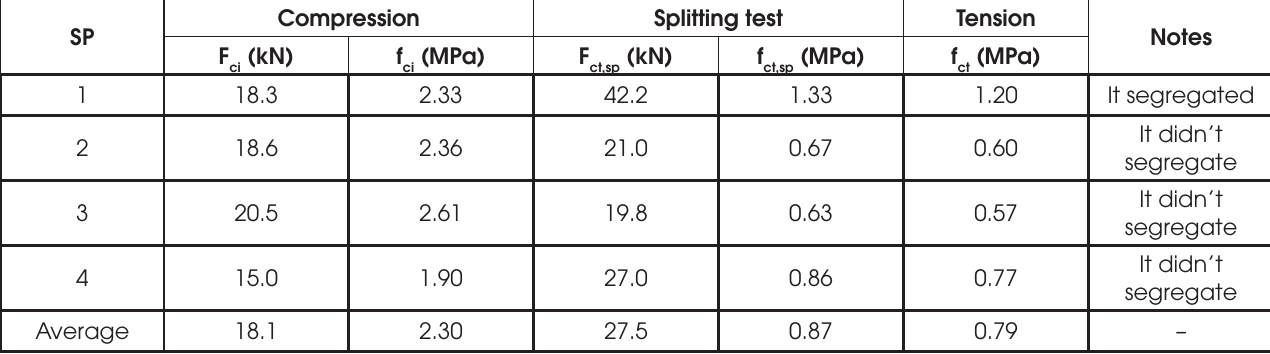
Description of 2 nd batch from SLCEB Compression Splitting test SP